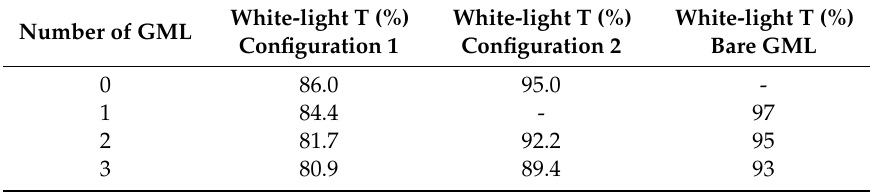
Table 3. Measured white-light transmission as function of both the number of GML and the TCE configuration